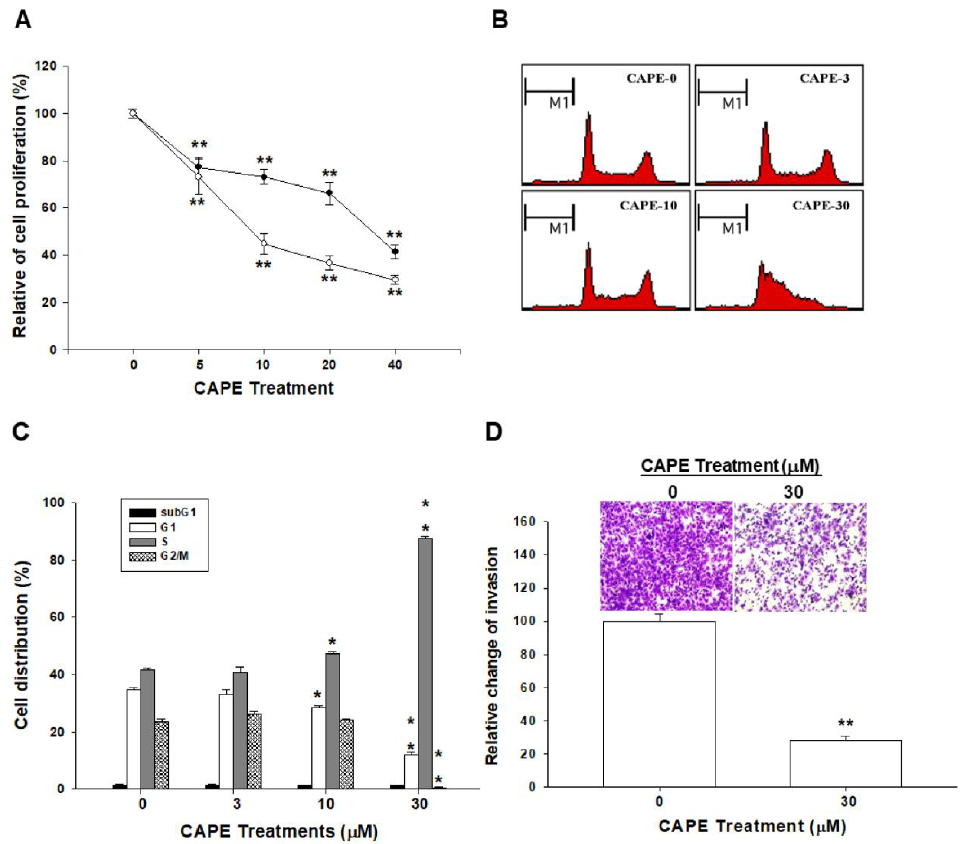
Figure 1. The anti-proliferative and anti-invasive effects of Caffeic acid phenethyl ester (CAPE) in TW04 cells. ( A ) TW04 cells were treated with various concentrations of CAPE for 24 h (●) or 48 h ( ○ ) and growth inhibitory effect was determined by the CyQuant cell proliferation assay. The data were presented as the mean percentage (±SE) of cells in each dose of the CAPE-treated group and compared with the control solvent-treated group (0 μM CAPE-treated, n = 8). ( B ) The represent DNA histograms of TW04 cells treated by different doses of CAPE for 24 h by standard flow cytometry. ( C ) The data